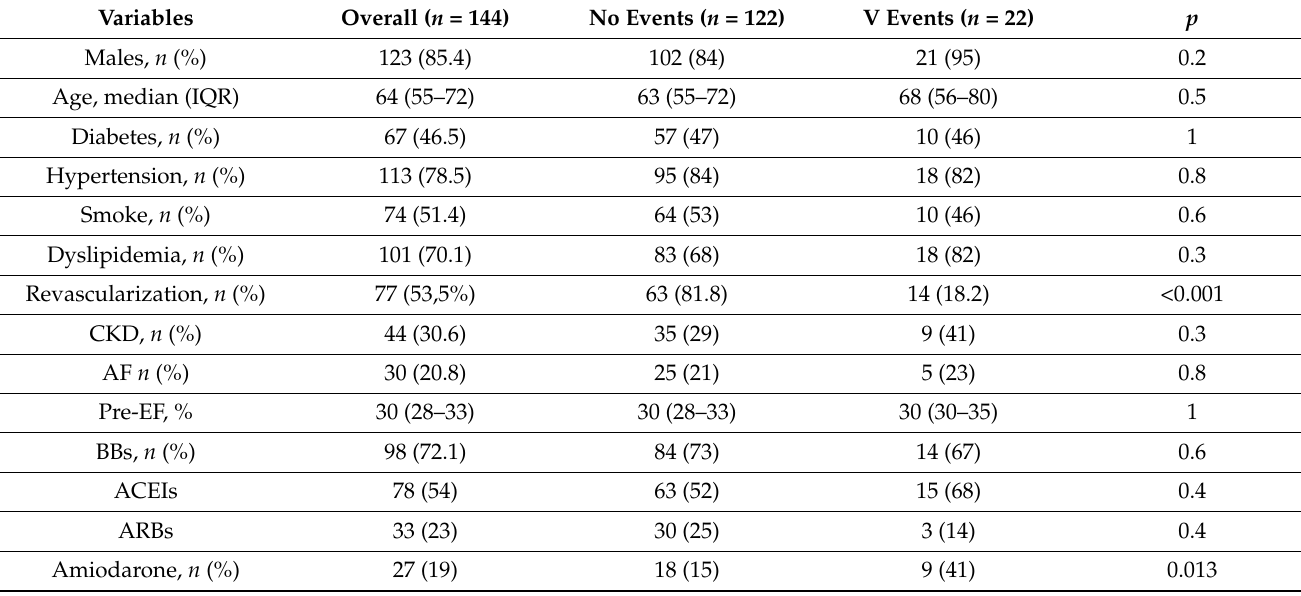
Table 1. Baseline clinical